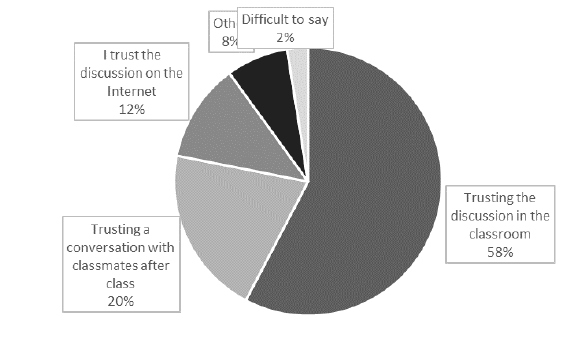
Figure. 3. Trust in the results of the discussion about euthanasia